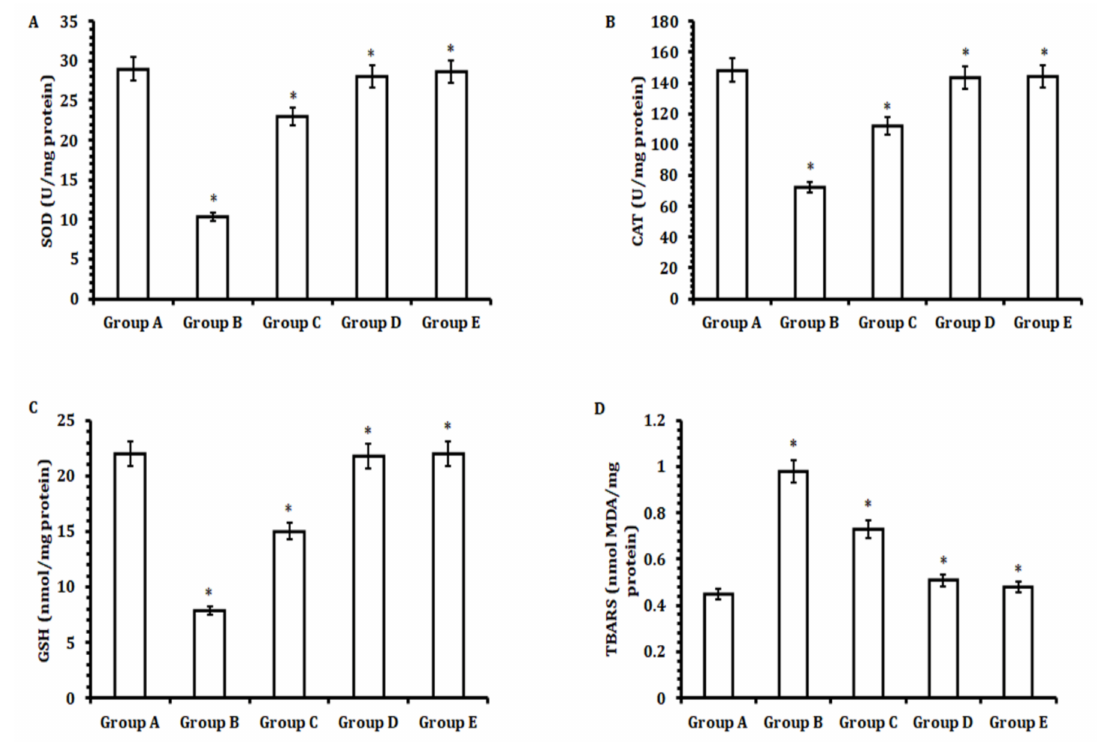
Figure 4. Effect of TA extract on the antioxidant enzymes (SOD, CAT, GSR, and MDA) of liver tissues initially treated with CCl 4 to induce liver toxicity. ( A ) Determination of superoxide dismutase (SOD) activity, ( B ) determination of catalase (CAT) activity, ( C ) determination of glutathione reductase (GSR) activity, and ( D ) determination of malondialdehyde (MDA) activity. The experiments were performed three times or more than three times and data are represented as the mean value ± SEM. A p -value less than or equal to 0.05 was considered to be statistically significant, i.e., * p ≤